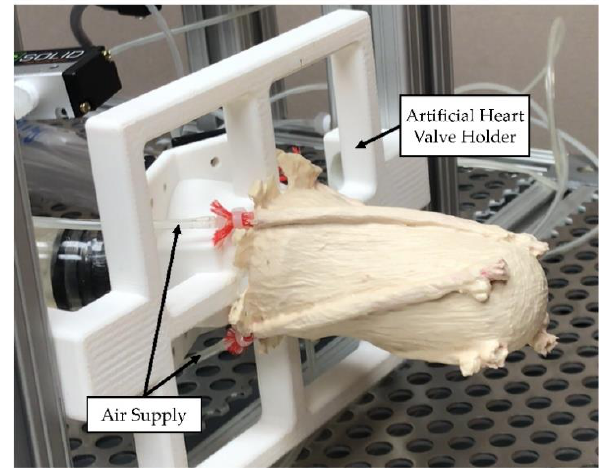
Figure 5. Setup of the validation experiment. All the actuators were loaded simultaneously.